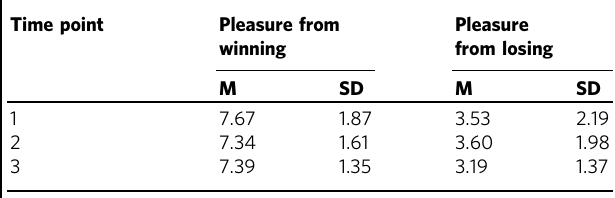
Fig. 5 Example trial of the fMRI task. Participants played a gambling task in which they could win or lose money for their best friend. On stimulus onset, a screen was presented showing how much they could win and lose. During the stimulus presentation, participants guessed heads or tails. After a fi xation screen, participants received feedback with whether they won or lost for their friend. Table 4 Pleasure experienced upon winning and losing for best